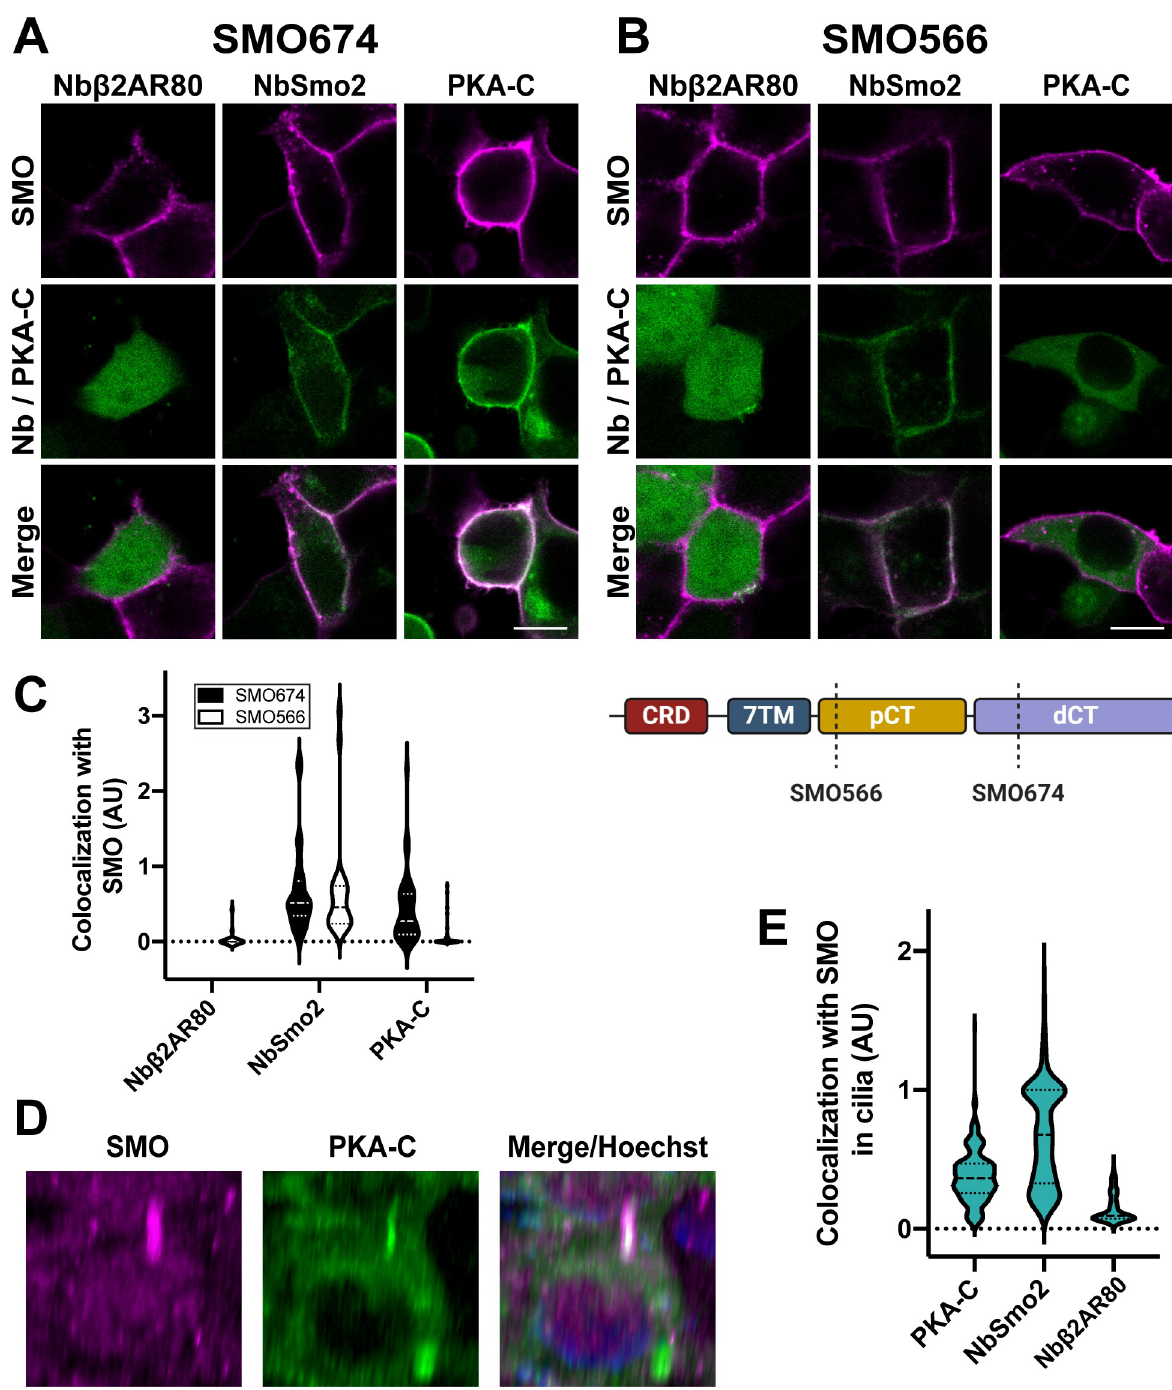
Fig 2. SMO uses its essential pCT domain to recruit PKA-C to the membrane. HEK293 cells expressing ( A ) FLAG-tagged SMO674 that contains the pCT or ( B ) FLAG-tagged SMO566 that lacks the pCT (see cartoon at lower right) were cotransfected with Nb β 2AR80-GFP, NbSmo2-YFP, or PKA-C-YFP. Confocal microscopy images show SMO (magenta) and co-expressed proteins (green). Scale bar = 10 μ m. ( C ) Quantification of colocalization for studies in (A) and (B). ( n = 29–121 cells per condition). Note that Nb β 2AR80 displayed a background-subtracted colocalization index of “0” in all SMO674-expressing cells examined. ( D ) Three-dimensional reconstruction of IMCD3 cells stably coexpressing FLAG-tagged SMO (magenta) with mNeonGreen-tagged PKA-C (green). After treatment with SAG21k to induce SMO accumulation in cilia, live cells were stained with anti-FLAG antibodies (magenta) and Hoechst (blue), then examined via confocal microscopy. See S3 Fig for images from cells expressing FLAG-tagged SMO with mNeonGreen-tagged NbSmo2 or Nb β 2AR80. ( E ) Quantification of colocalization between SMO and PKA-C,